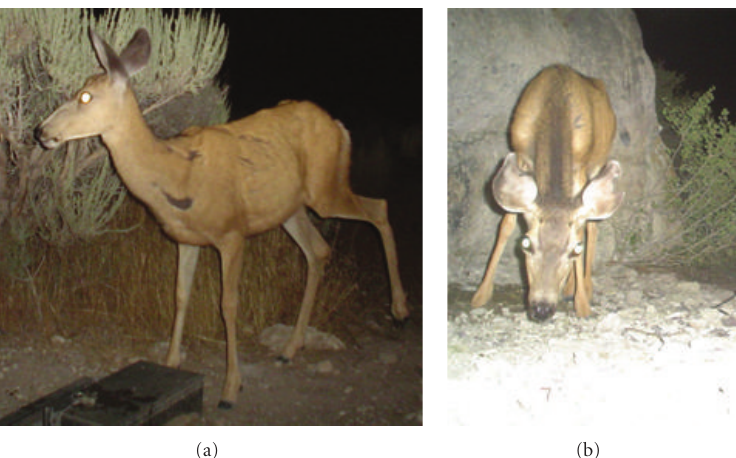
Figure 2: Photographs of female mule deer taken by remote cameras showing distinguishing features including scars (a) and notches in both ears (b) that we used to identify individuals at water sources in Utah, USA,